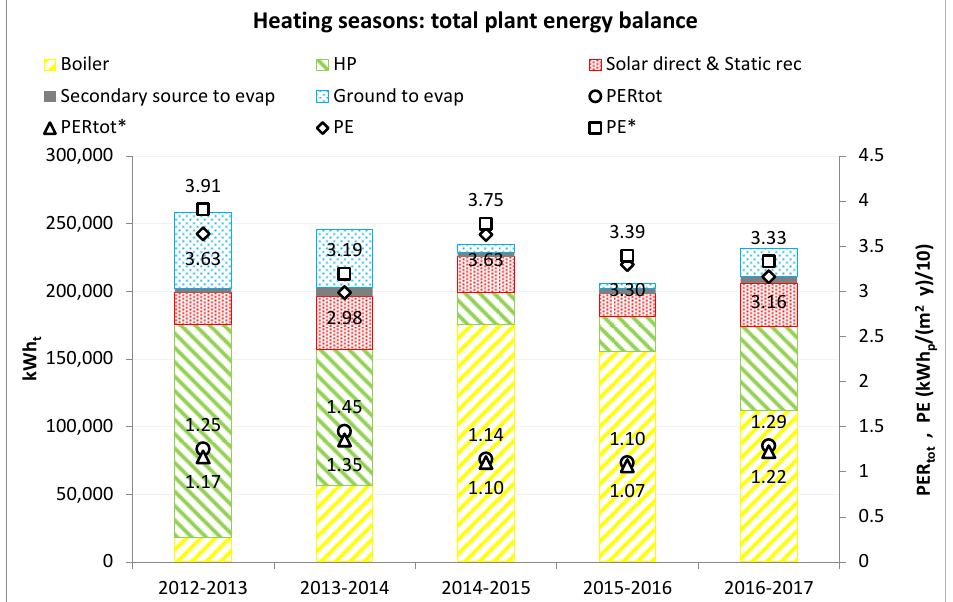
Figure 10. Seasonal energy contribution from different sources (energy from heat pumps generators (HP), from heat pump evaporators both from ground and secondary sources, heat recovered by static recuperator, solar direct, and from boiler, expressed as thermal energy) to the global (heating + ventilation) energy need, total PER, and specific primary energy consumption (PE). PERtot* and PE* were calculated considering pumps’ electricity consumption as well.